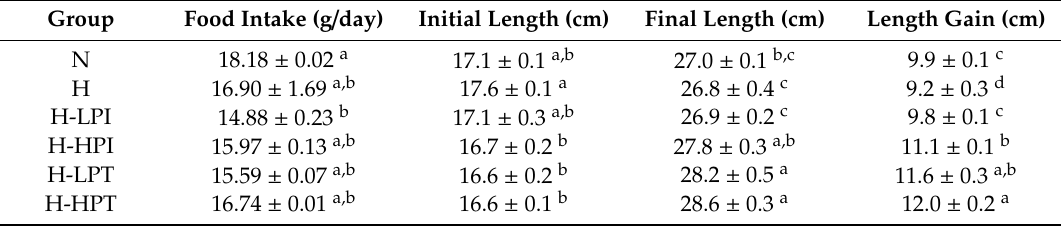
Table 2. E ff ects of patchouli essential oil inhalation on food intake and body length.